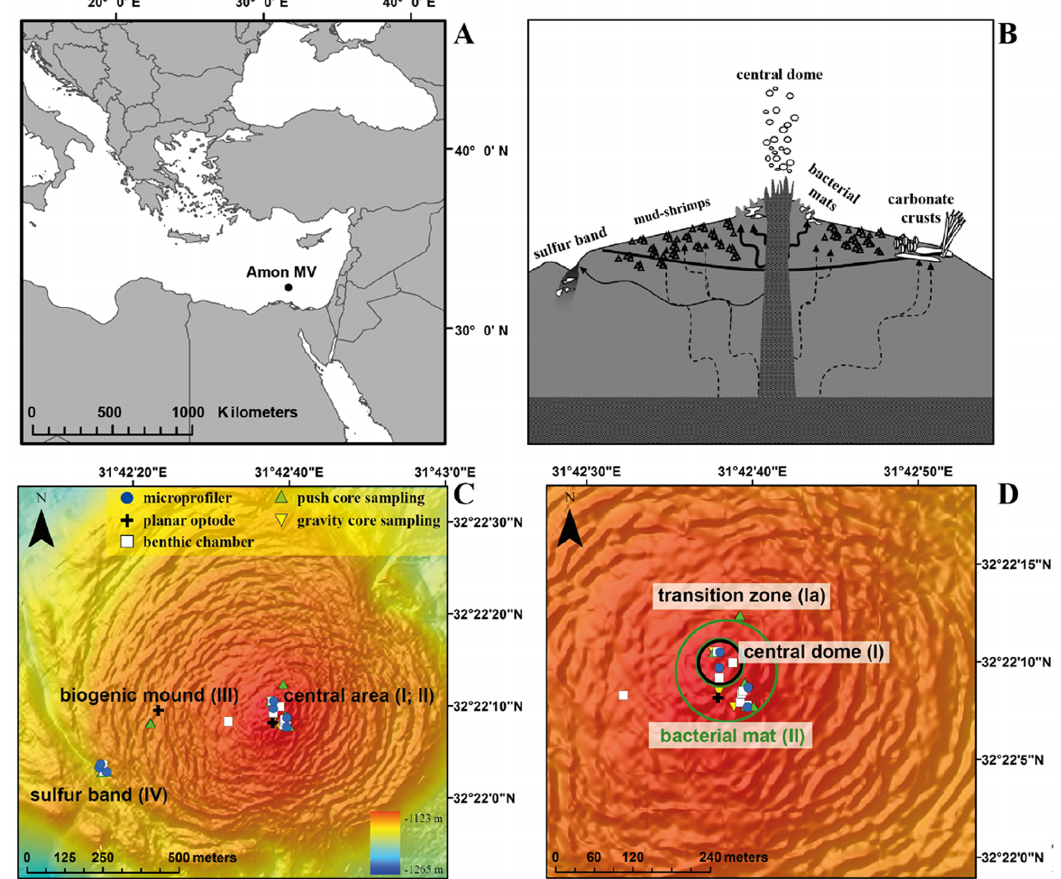
Fig. 1. Sampling sites. (A) The Amon MV is located on the Nile deep-sea fan of the Eastern Mediterranean. (B) Schematic drawing of habitats at the Amon MV. The habitats are not scaled to the same dimensions. (C) , (D) Positions of all in situ instrument deployments and push core sampling at the Amon MV in 2006 and 2009. In the central area bacterial mats (II) surround the central dome (I). The different tools are color coded: microprofiler as blue circles, planar optode as black crosses, benthic chamber as white squares, push cores as green triangles (up) and gravity cores as yellow triangles (down) (map modified from Dupr´e et al.,